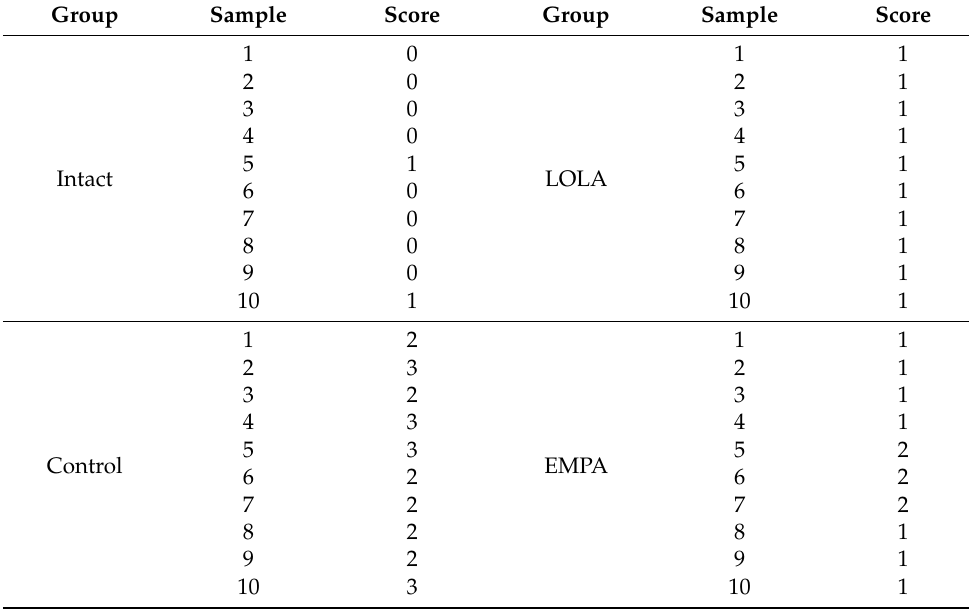
Table 1. Primary cholestasis scores for all tissue samples.